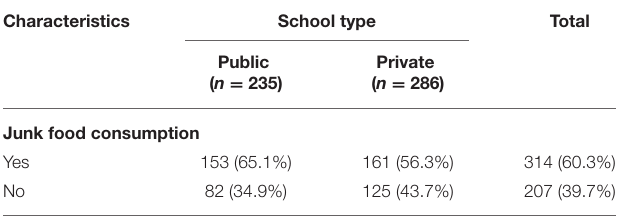
TABLE 3 | Status of junk food consumption ( n = 521).